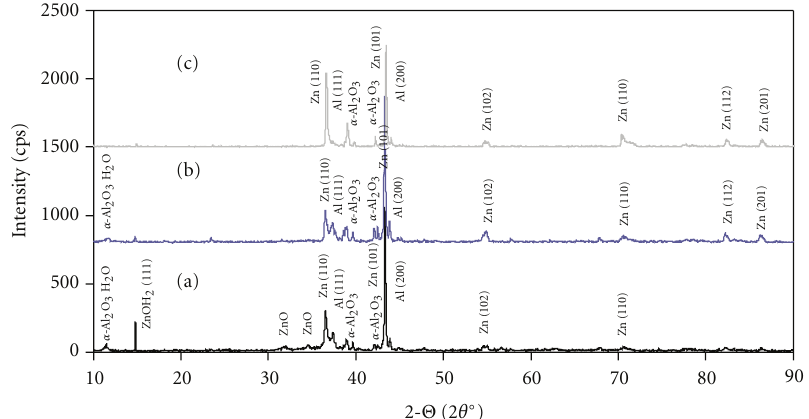
Figure 7: X-ray di ff raction pattern of the Zn-10Al-1.5Cu alloy in 0.3M NaCl, at (a) 45 ◦ C, (b) 25 ◦ C, and (c) 7 ◦ C solution temperature.